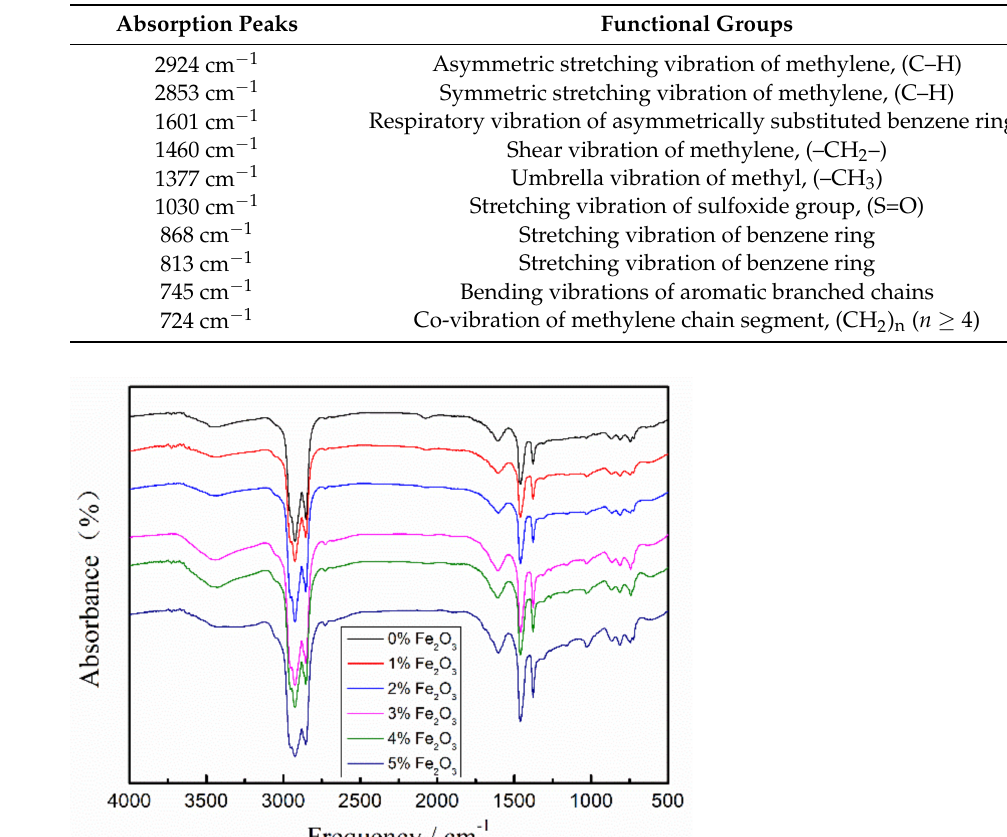
Table 3. Spectral analysis of main absorption peaks in asphalt composites.